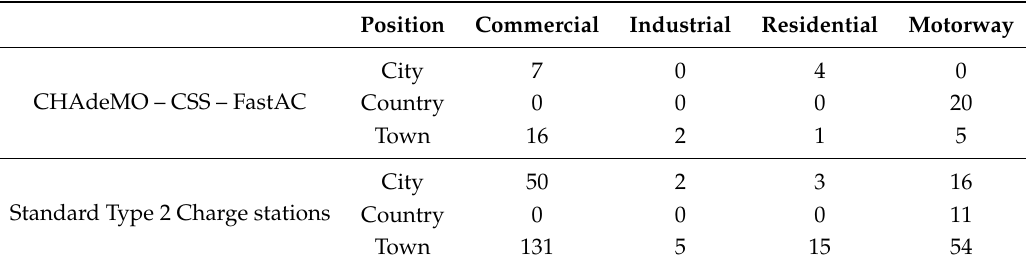
Table 2. Number of charging point by category and position.